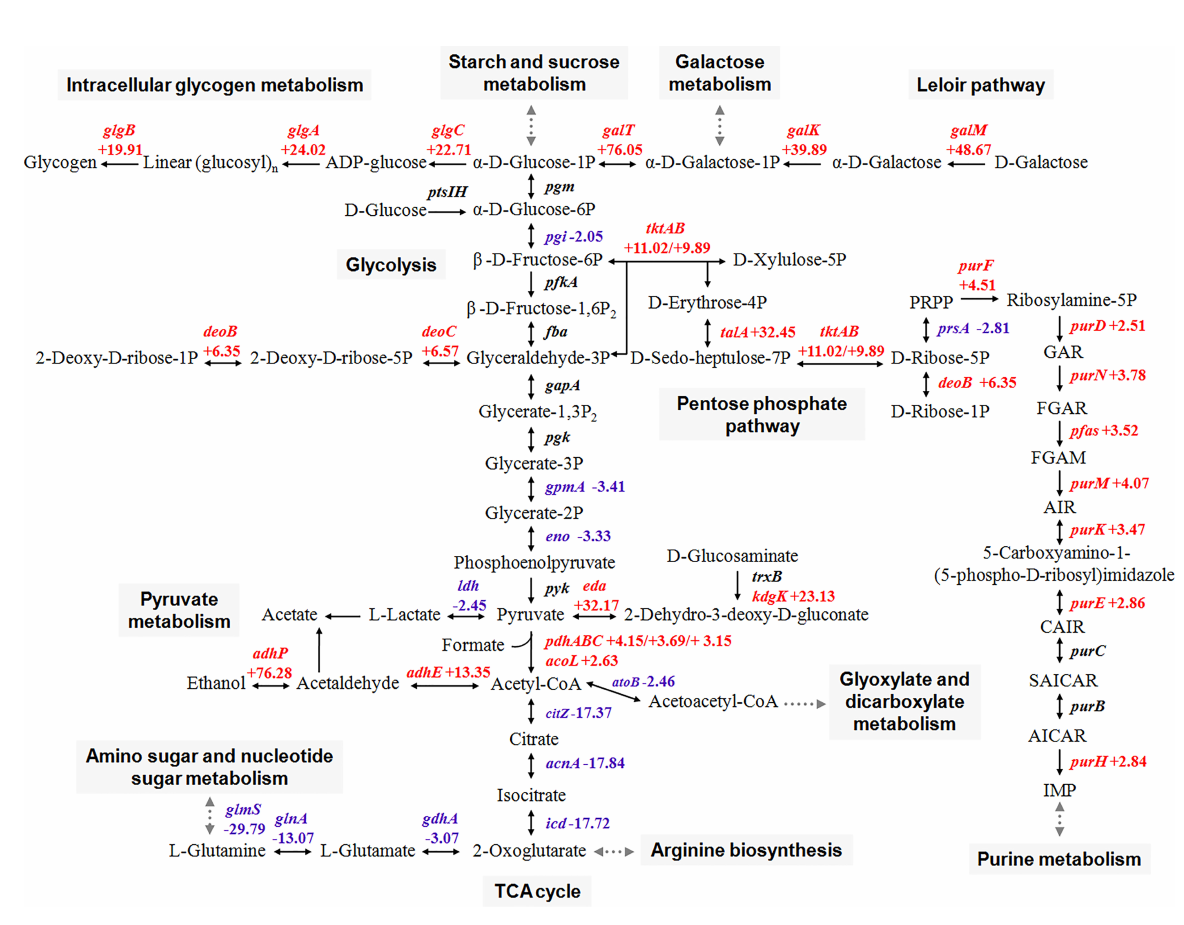
FIGURE 3 Schematic representation of main carbon metabolism pathways in S. suis that are differentially regulated in the presence of glycogen. Red color, upregulated genes; blue color, downregulated